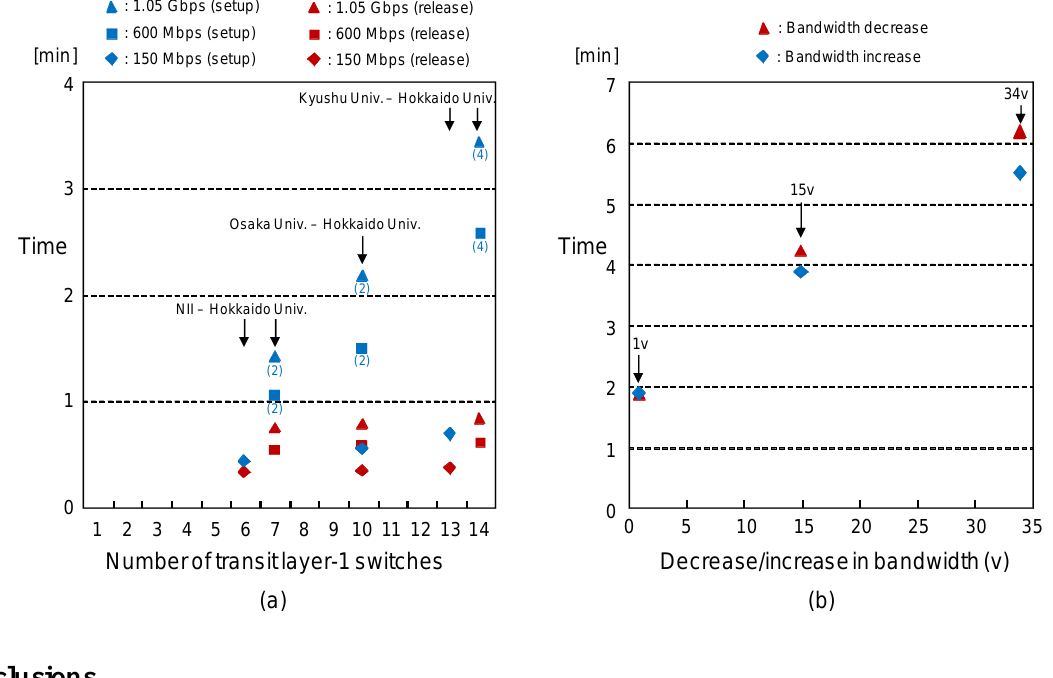
Figure 8. Performance of layer-1 BoD services. (a) Layer-1 path setup/release time. (b) LCAS operation